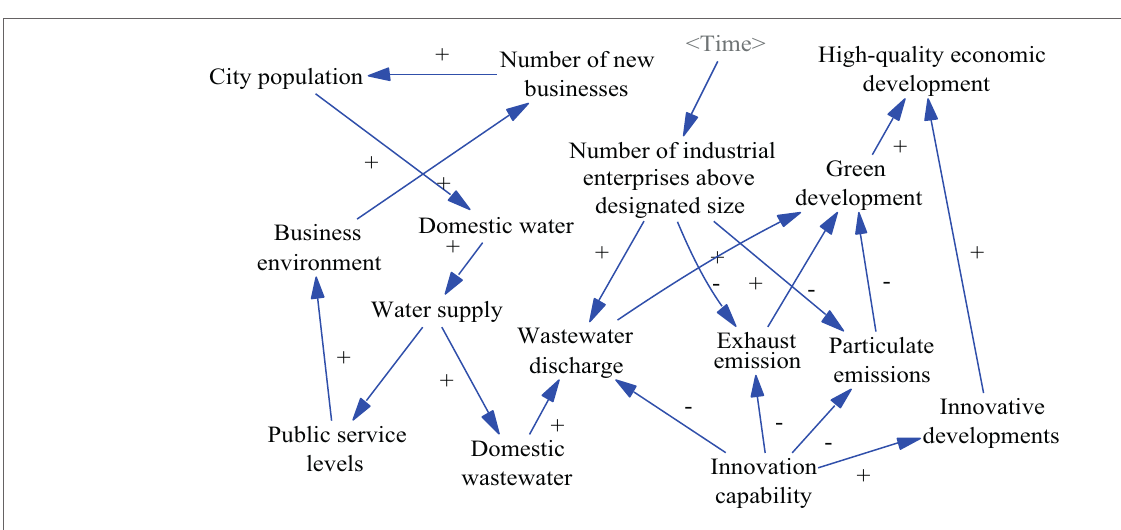
FIGURE 4 | Resource environment sub-system causality diagram.